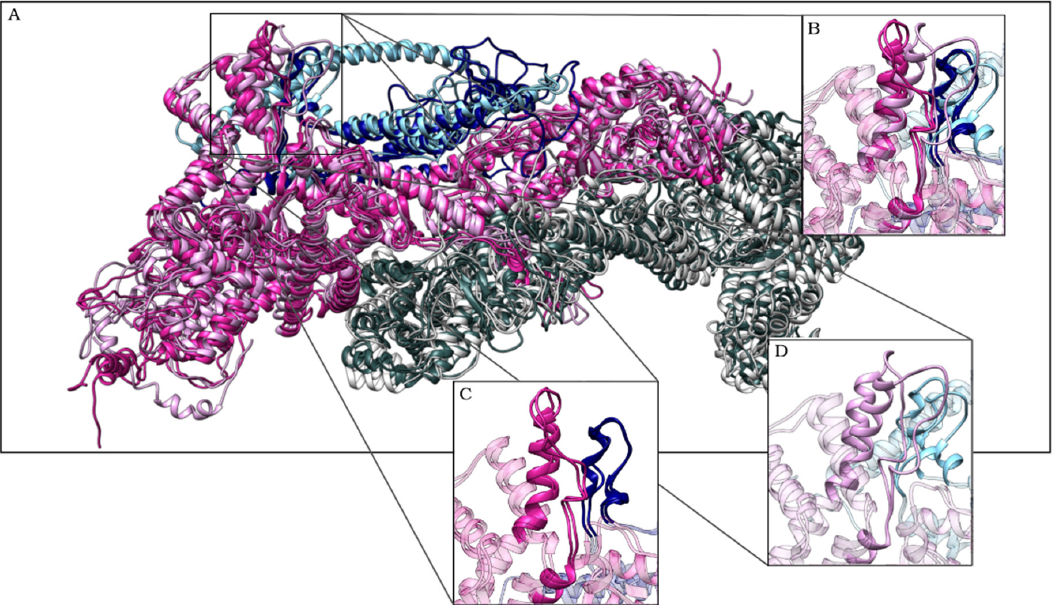
Figure 4. Superimposed structures of the first cluster centroid for both replicas from the WT complex (darker colors) and the R87C complex (lighter colors) ( A ). Representation of CYFIP2 in magenta, NCKAP1 in gray, and WAVE1 in blue. Detail of residues 80 – 120 from CYFIP2 and residues 131 – 151 from WAVE1. Superimposed models ( B ), only WT models ( C ), and only R87C models ( D ). Note how this loop diverges for the R87C variant compared to the WT.